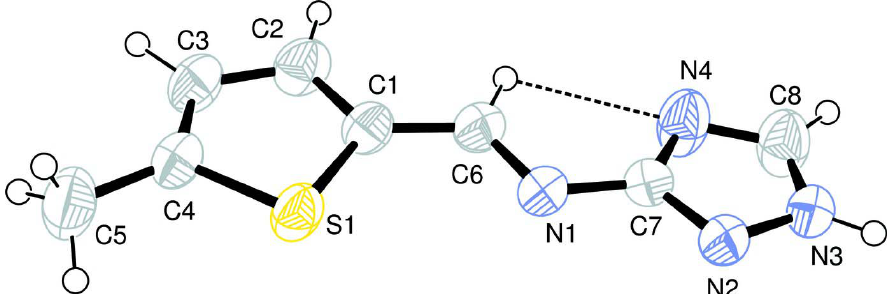
Figure 1 ORTEP - 3 for Windows (Farrugia, 1997) drawing of the title compound, C thermal ellipsoids are drawn at the 50% probability level. H-atoms are shown by small circles of arbitrary radii. The intramolecular H-bonding is shown by dashed lines.